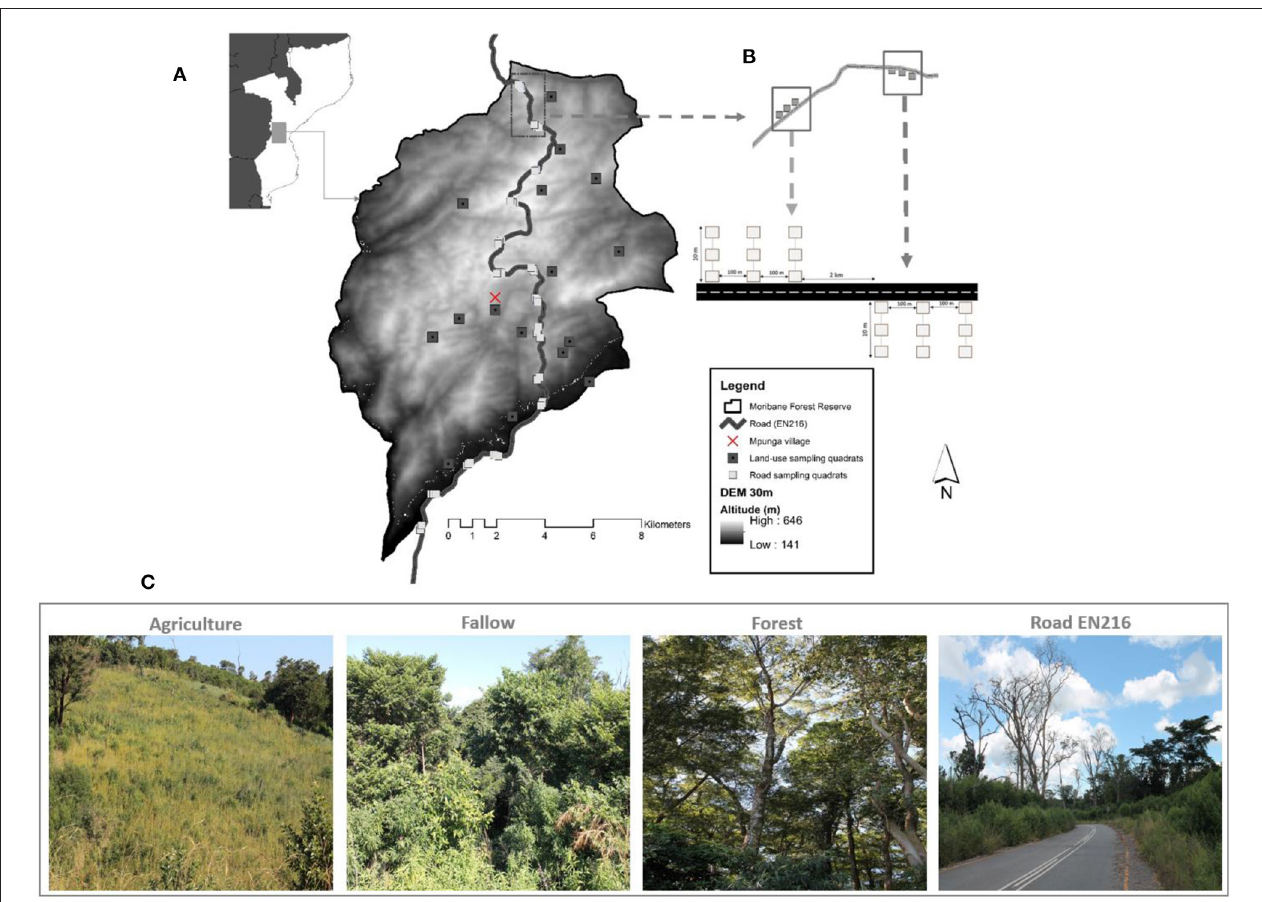
FIGURE 1 | Moribane Forest Reserve, Sussundenga district, Manica province with the distribution of land-use sampling quadrats and road sampling quadrats along paved road EN 216; the background map shows the national location of MFR in Mozambique (A) . The sets of 3 transects for each side of the Road was 2km apart, and the three transects contained three quadrants 5m apart (B) . Land use types targeted in this study in MFR (C) . Photos by Sá N.